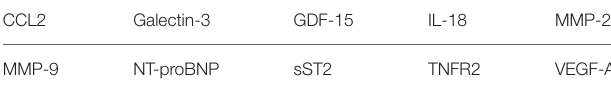
TABLE 1 | Biomarkers used for